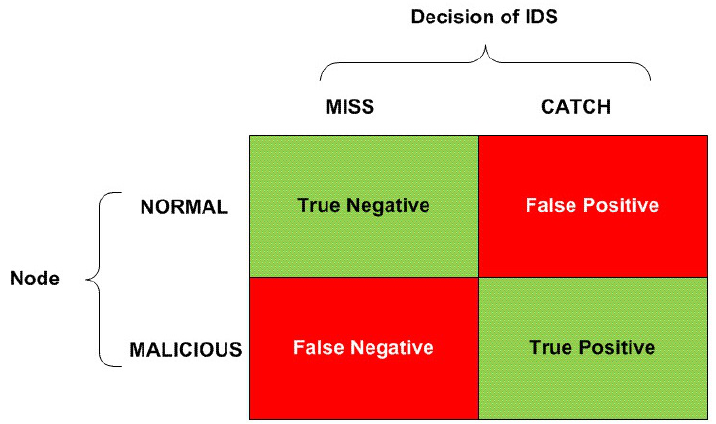
Figure 10. All possible detection results of an